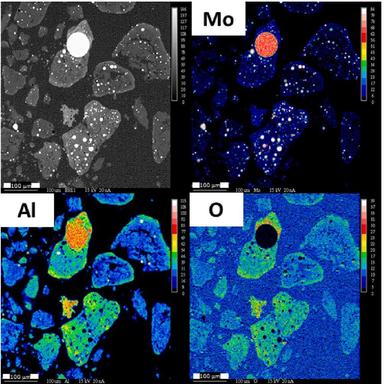
BSE image of the as-collected particles and EPMA elemental mapping of Al, Mo, and O contents.